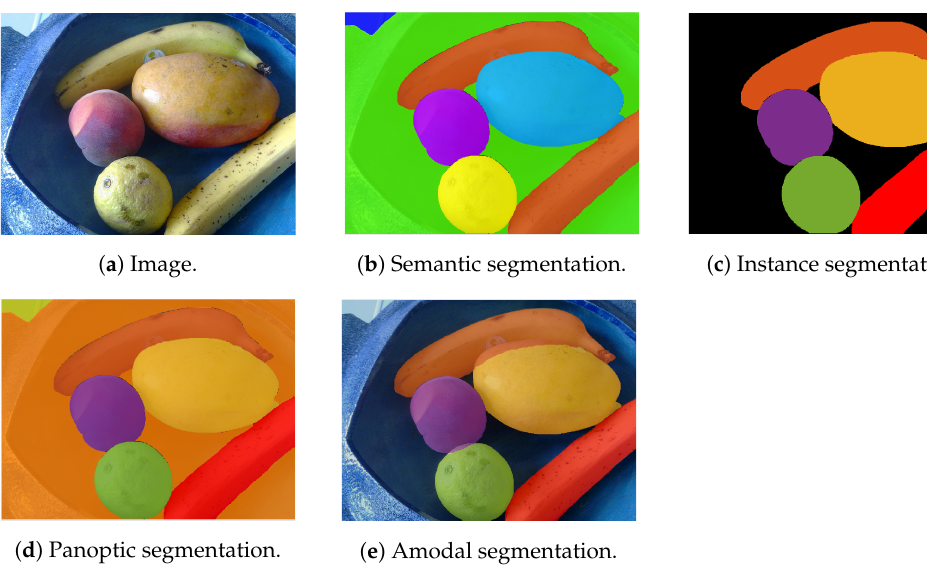
Figure 3. Different types of image